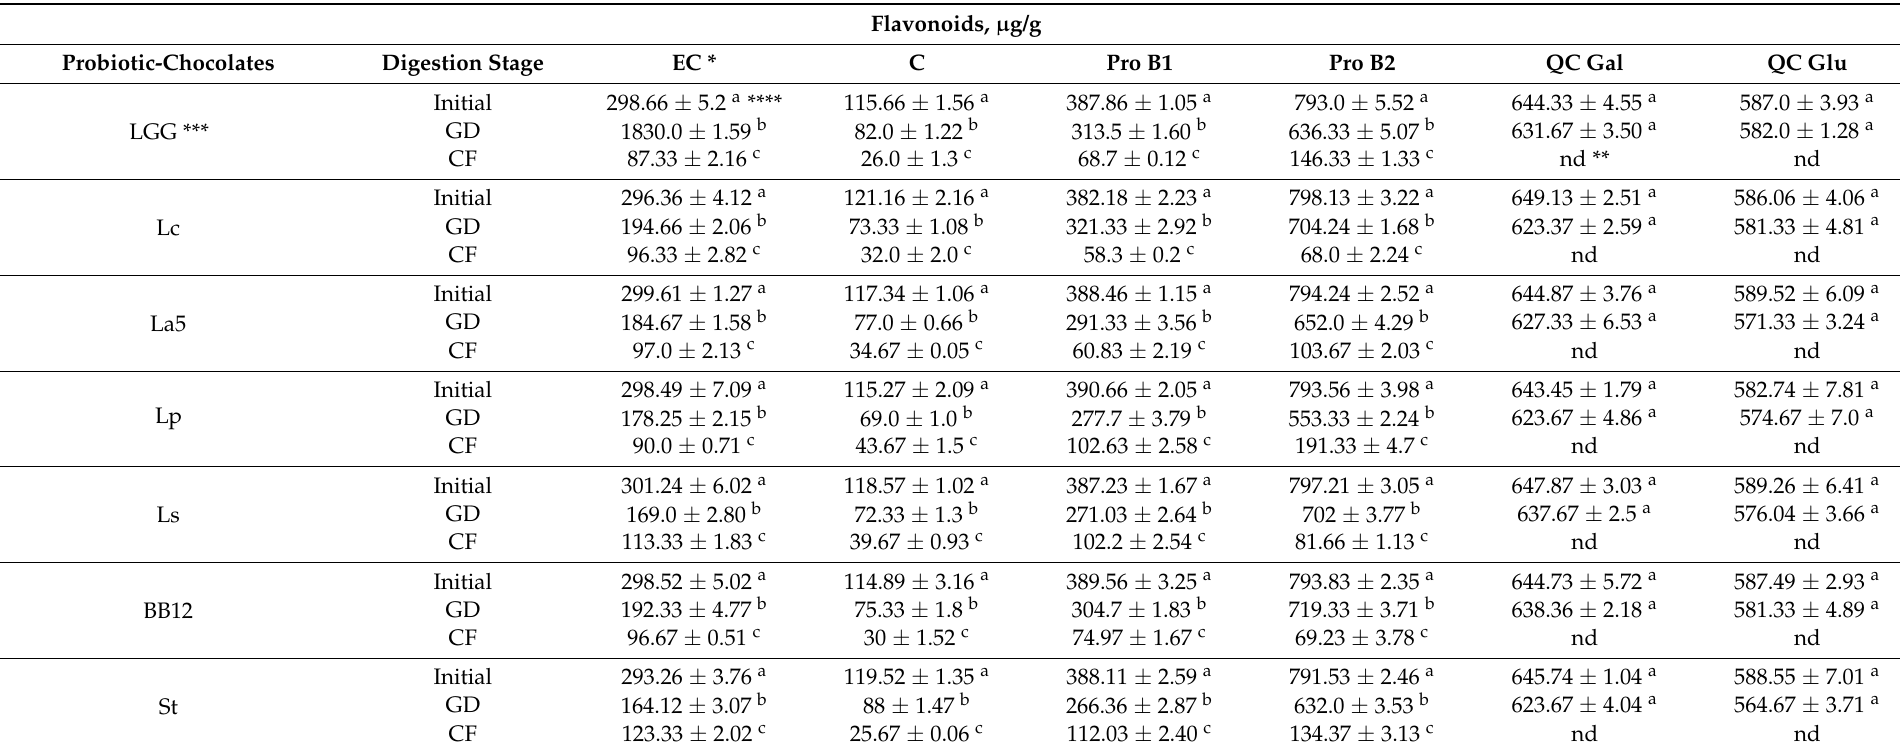
Table 1. Quantitates ( µ g/g) of major flavonoids isolated during in vitro digestion of probiotic-chocolate (70% cocoa powder). Flavonoids, µ